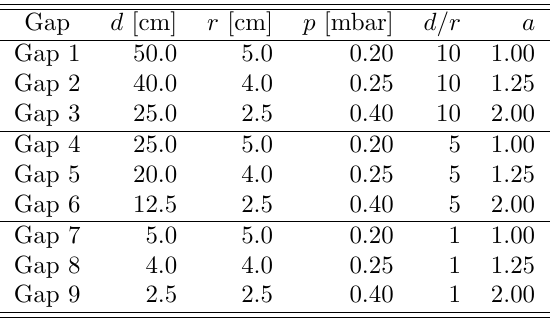
Table 1: Parameter values are chosen for similarity ver- ification.